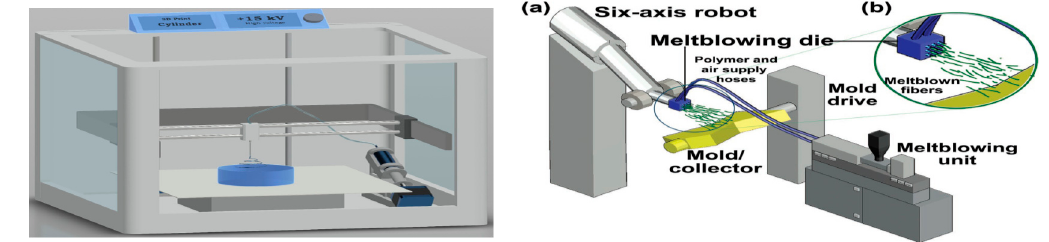
Figure 12. Illustration of a 3D electro-spinning setup ( left ) and robotic fiber assembly and control system (RFACS) ( right ), the integration of a six-axis robot with melt blowing system [66].